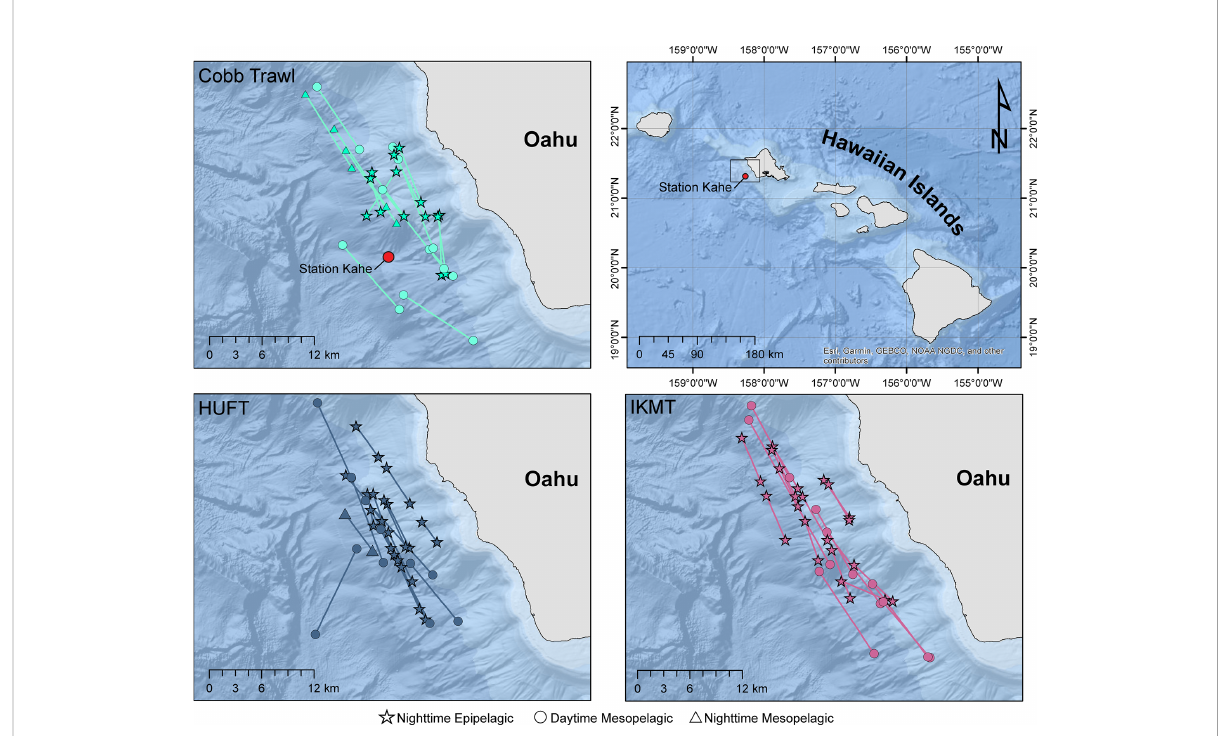
FIGURE 2 Location of Cobb, HUFT, and IKMT oblique (epipelagic) and horizontal (mesopelagic) net tows on the southwest coast of Oahu Island, Hawaii. Symbols indicate whether the transects were nighttime epipelagic ( ☆ ), nighttime mesopelagic ( Δ ), and daytime mesopelagic ( O ). In the top two panels, the point indicates Station Kahe (21° 20.6 ’ N, 158° 16.4 ’ W) from the Hawaiian Ocean Time-Series (https://hahana.soest.hawaii.edu/hot/).